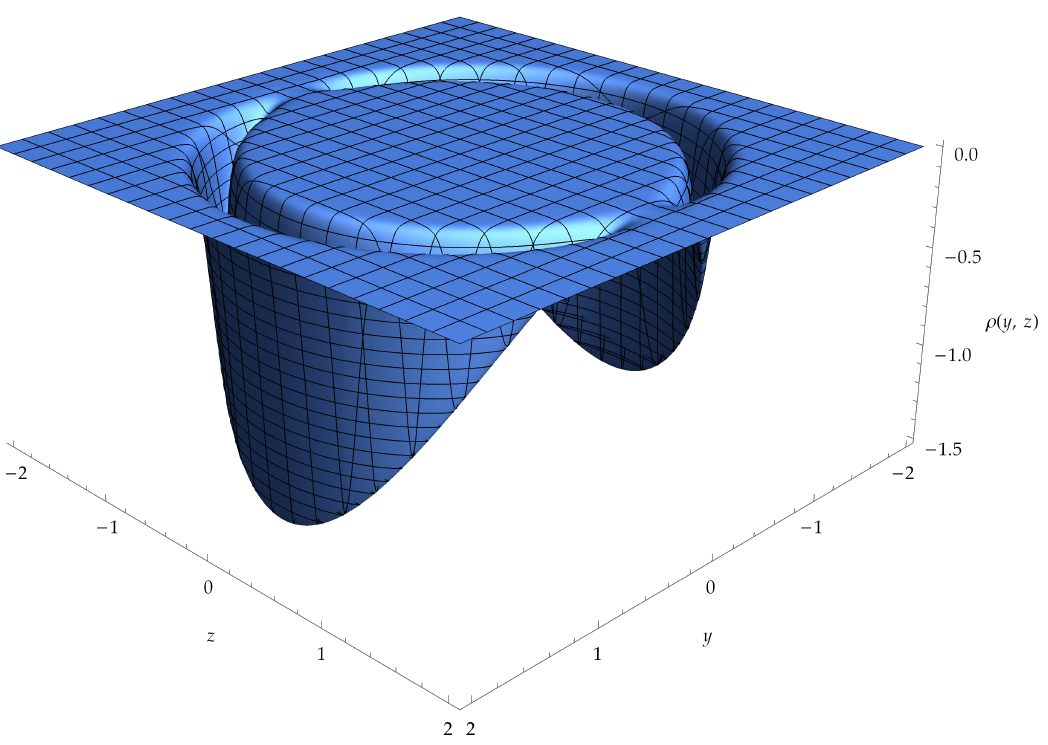
Figure 5: The distribution of energy density around a warp drive bubble with v = 2, R = 1.5, and (cid:34) = 0.1 moving along the positive z